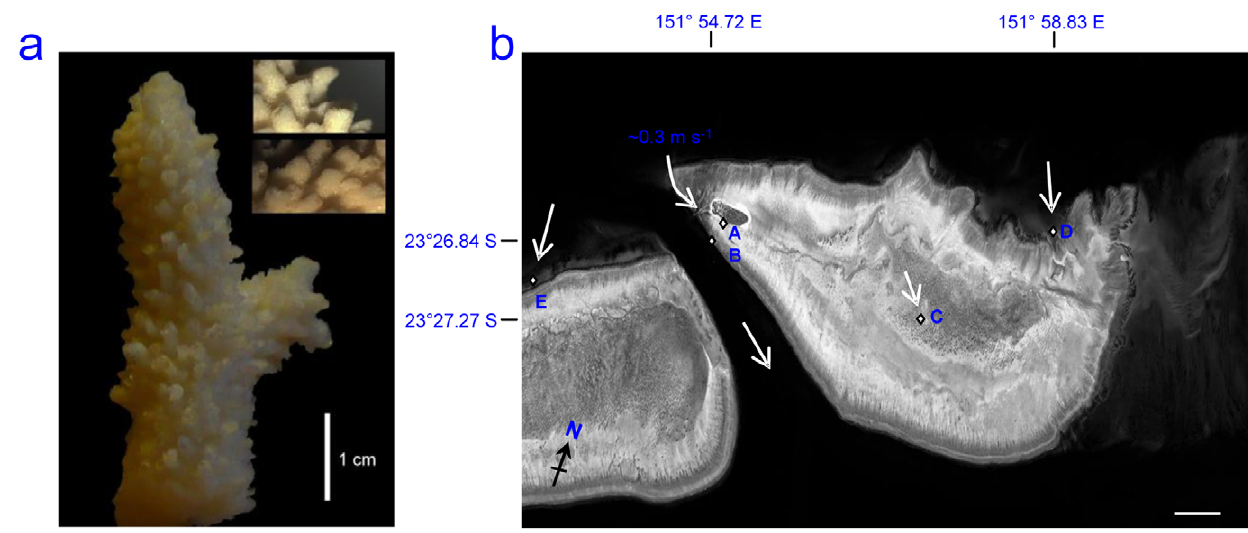
Figure 8. Example of novel methodology utilised in this study and site location; a) Photograph of replica coral nubbins used in experiment with close up sections of the mould (insets), b) Site map showing, Heron Island GBR, Australia (23 6 27 9 S, 151 6 55 9 E), location of main study site (A) the Reef Flat and those used in spatial sampling; (B) Coral Gardens 23 6 26.839/151 6 54.717 (C) Lagoon 23 6 27.272/151 6 57.921 (D) 3 rd /4 th Point 23 6 26.146/151 6 58.833 (E) Wistari 23 6 29.081/151 6 54.015. Arrows depict water current direction at time of sampling with direction and speed noted. Samples were taken on calm days, one hour before high tide, with wave speed W S , 0.5 m/s and wave heights H S , 0.5 m. Scale bar =1 km.